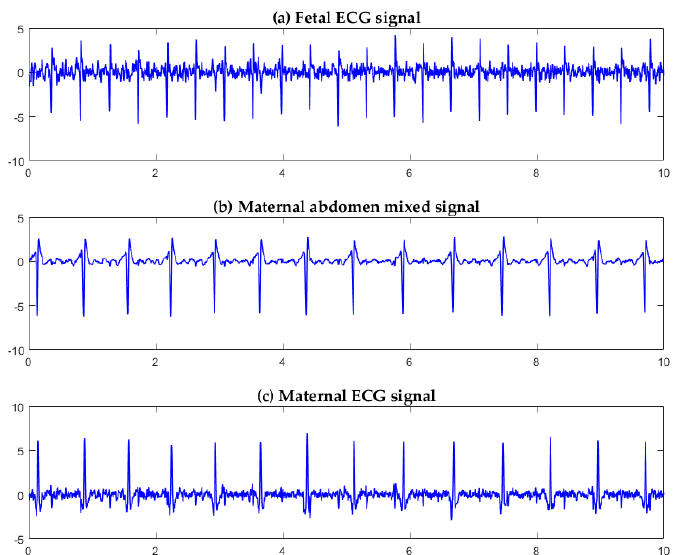
Figure 9. Three source component signals separated by the FastICA algorithm for Ch1, Ch3, and Ch4 signals from the pregnant woman (Figure 8): ( a ) fetal ECG signal; ( b ) maternal abdominal mixed signal; ( c ) maternal ECG signal.